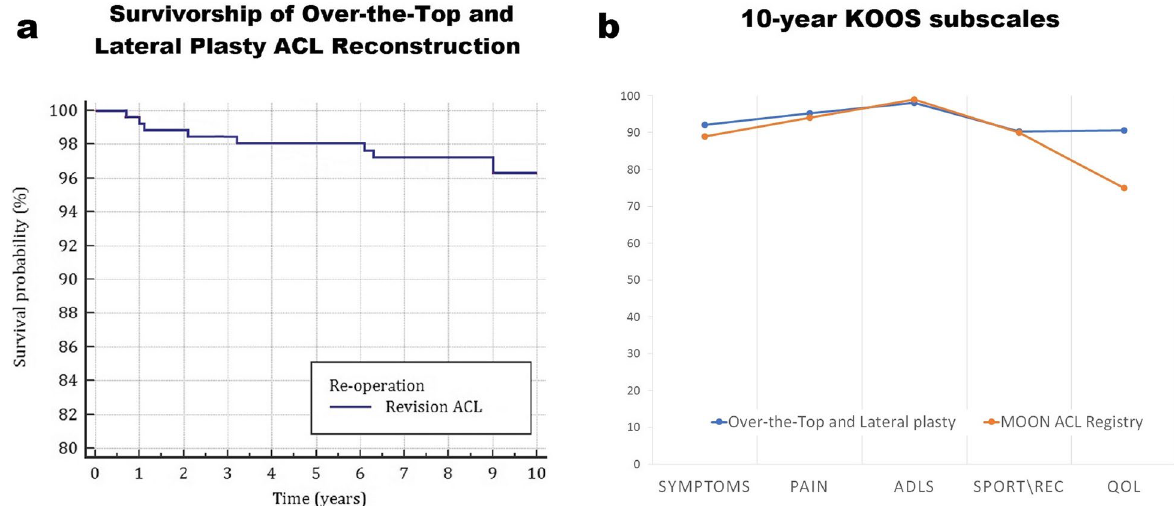
Fig. 7 a‑b Survival curve of ACL over the top and lateral plasty ACL reconstruction at 10 years ( a ); 10 year KOOS Subscale of Over-the-top (blue) and MOON ACL Registry (orange) ( b